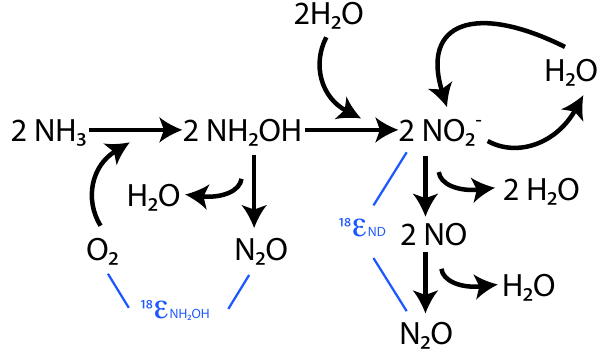
Fig. 1. During ammonia oxidation, the oxygen atoms incorporated into N 2 O come from either O 2 or H 2 O. The δ 18 O-N 2 O depends upon the isotopic signatures of these two substrates as well as iso- tope effects ( 18 (cid:15)) that may be associated with the individual forma- tion mechanisms, hydroxylamine ( 18 (cid:15) NH2OH ) decomposition and nitrifier-denitrification of nitrite ( 18 (cid:15) ND ).